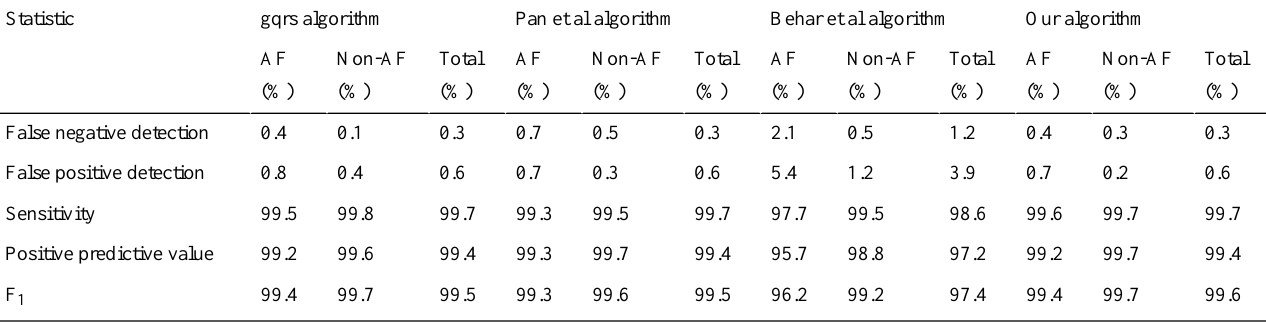
Table 1. Mean statistics for the tested algorithm’s performance detecting R peaks in atrial fibrillation (AF), non-AF, and the total strips in the MIT-BIH Arrhythmia Database.